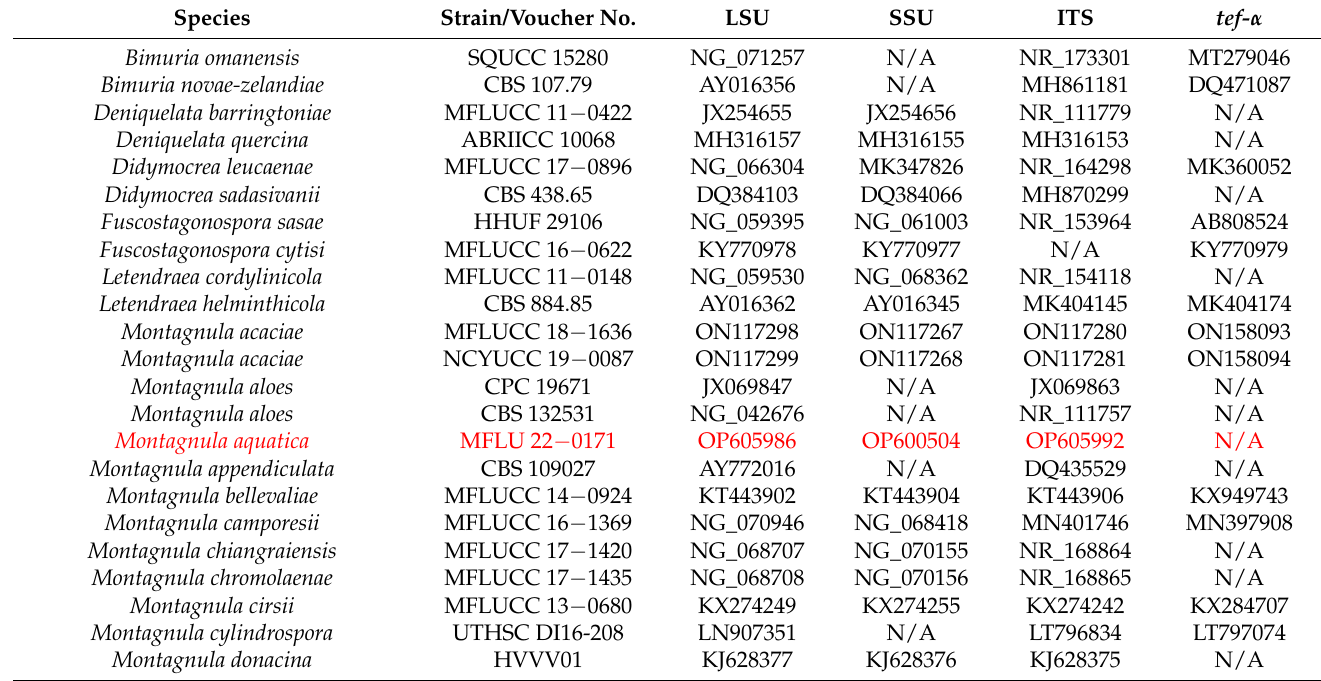
Table 6. Sequence data were used for phylogenetic analyses with the corresponding GenBank accession numbers. The newly generated strains are in red. N/A: Not available. Species Strain/Voucher